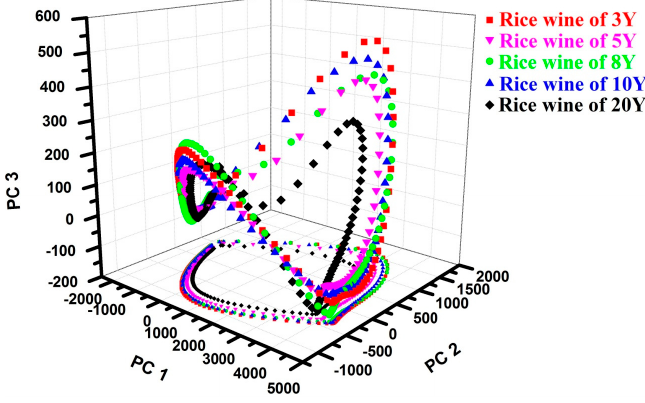
Figure 6. Classification results based on the compressed signal values.